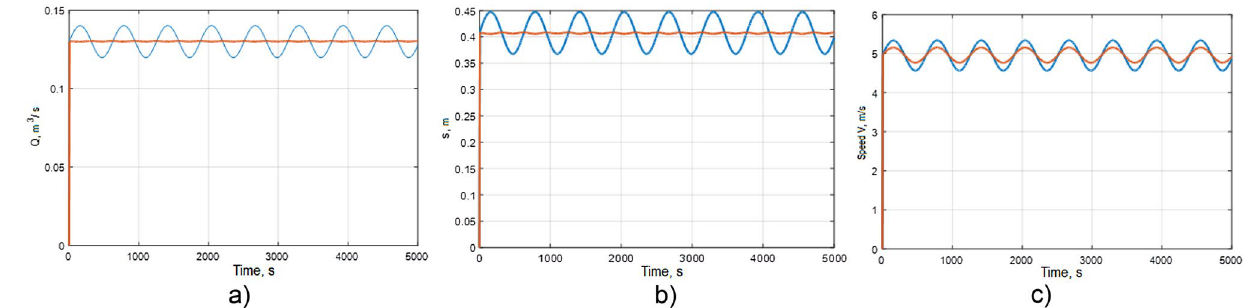
Fig. 10 Comparison of the system operation without compensation and with compensation parameters: a productivity; b coordinates of the fall of the paper pulp jet on the paper-making machine grid; c change in the speed of paper pulp inlet from the pressure device